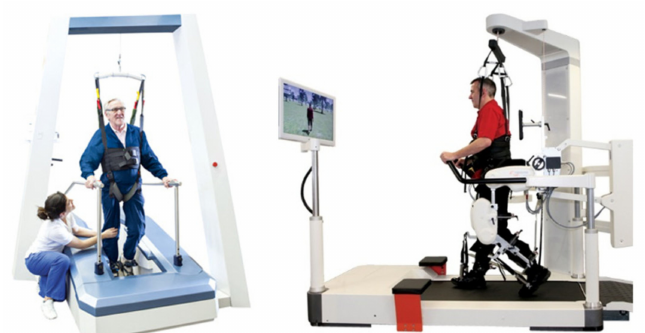
Figure 3. Robot-assisted gait trainer. Lyra (Thera Trainer, Hochdorf, Germany) (left); Lokomat (Hocoma, Volketswil, Switzerland) (right).